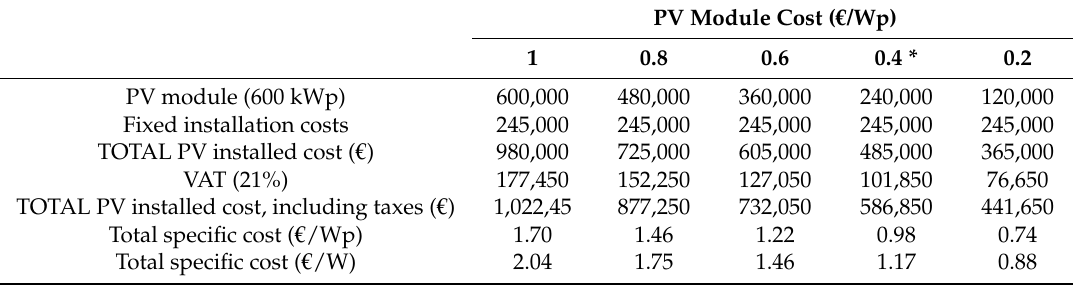
Table 11. Cost of a PV system at 600,000 Wp (500,000 W